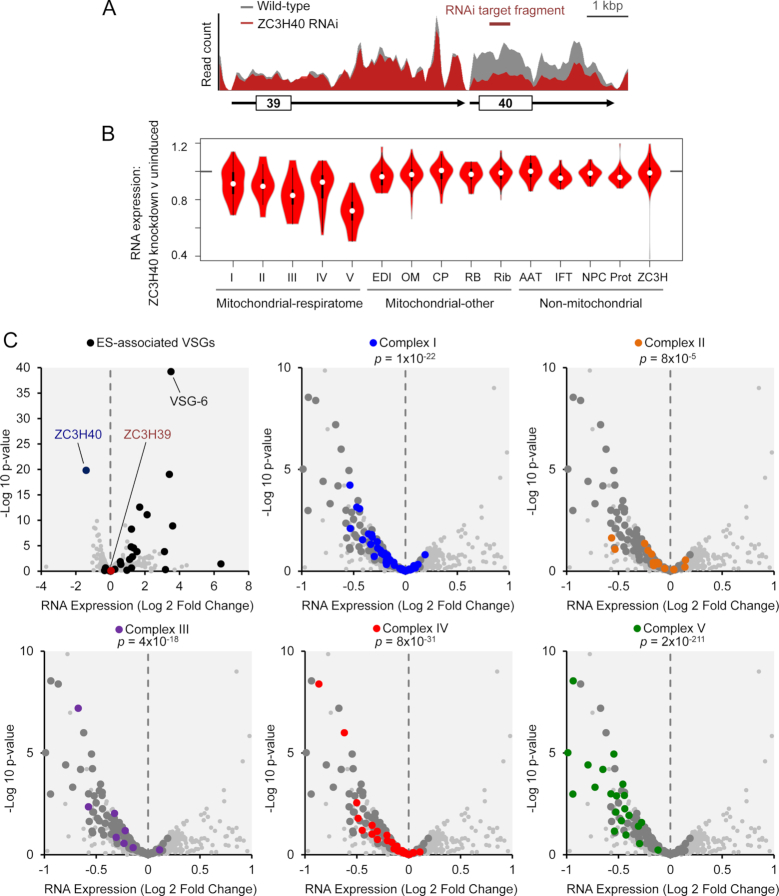
Transcriptome analysis following ZC3H40 knockdown in bloodstream form T.brucei. RNA-seq analysis following ZC3H40 knockdown (uninduced versus 72 h knockdown; also see Supplementary Data File S1, Sheet S2; Supplementary Figure S2). (A) The plot shows reads mapped across the ZC3H39/40 locus in control cells (grey) or following ZC3H40 knockdown (red). Untranslated regions are indicated by black lines with arrowheads. (B) Violin plots for gene cohorts showing mRNA expression following ZC3H40 knockdown (RPKM). White symbols show the medians, box limits indicate the 25th and 75th percentiles and whiskers extend 1.5 times the interquartile range; AAT, amino acid transporters; CP, carrier proteins; EDI, editing complex; IFT, intraflagellar transport; NPC, nuclear pore complex; OM, outer membrane; Prot, proteasome; RB, RNA-binding complex; Rib, ribosome. (C) Volcano plots showing the full transcriptome (>7000 genes). Values are RPKM averages for two independent clones. ZC3H40 (blue) and ZC3H39 are shown in the top-left panel. ES-associated VSGs, all expression site associated VSGs are telomere-adjacent. In other panels, the larger grey data-points indicate the full respiratome set. P-values derived from chi-squared tests using transcripts down-regulated >20%.